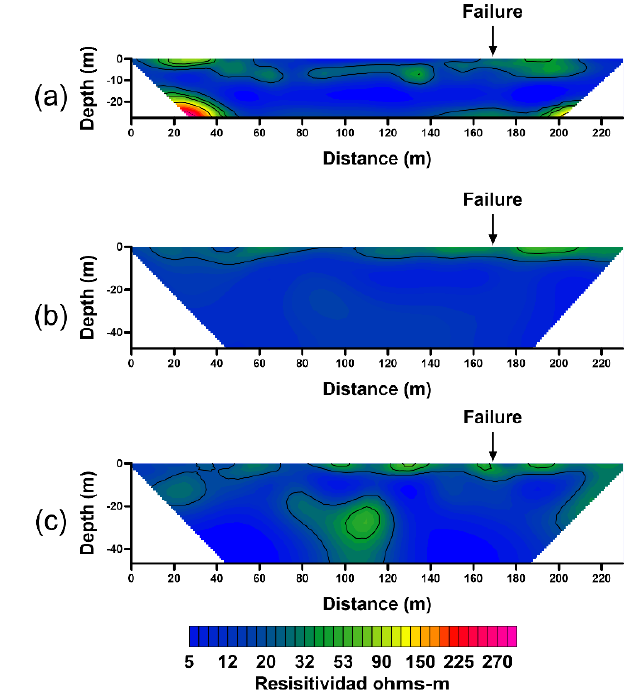
Figure 4. Profiles with 10m opening between electrode.